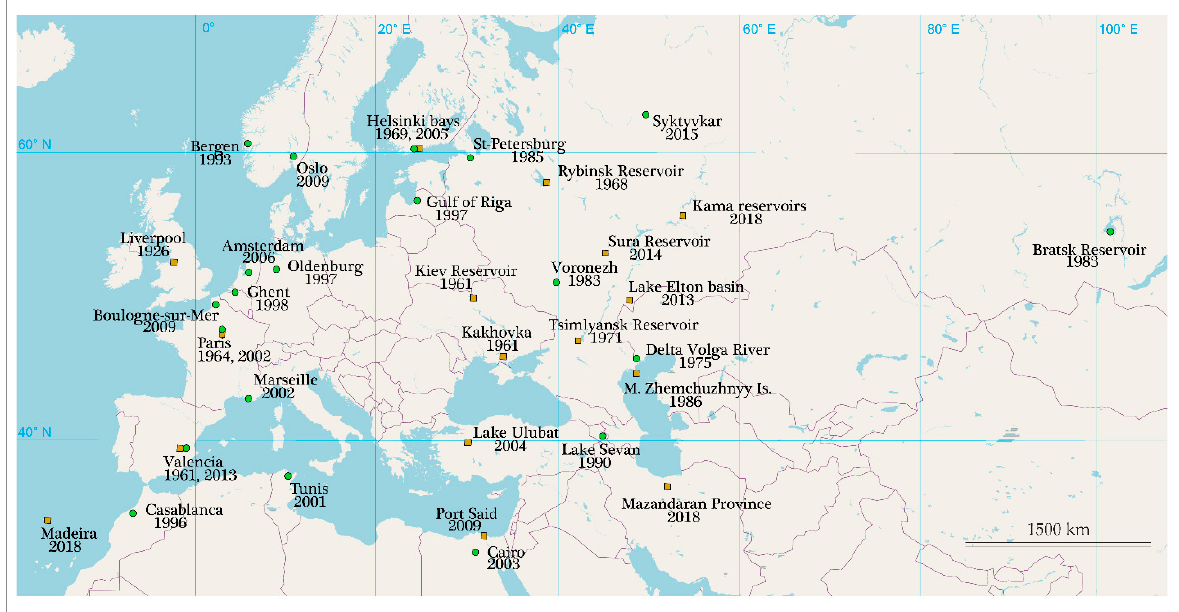
Figure 1. Sites of findings of Acanthocyclops americanus in Eurasia and North Africa. Green circles: personally examined by the author; orange squares: based on the literature ([1–3,10,25,30–35]; [36–38] as A. robustus ; [39] as A. trajani ).